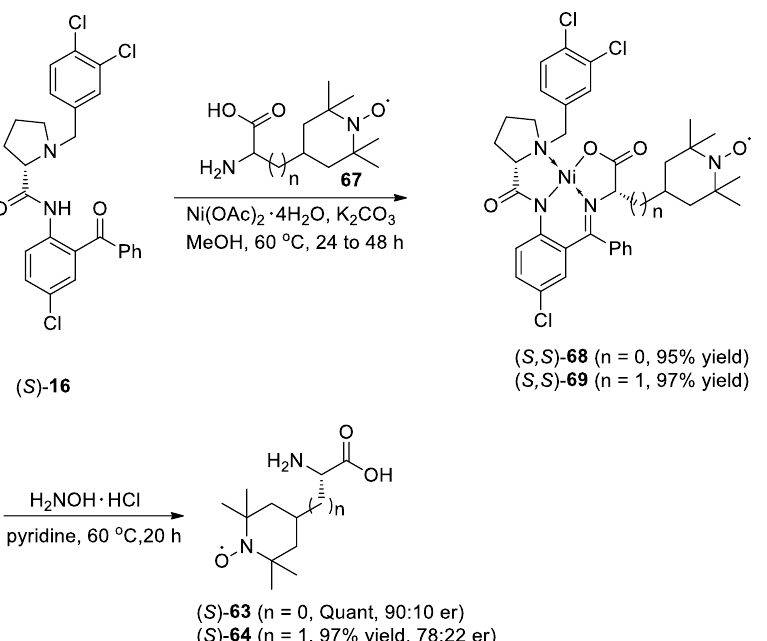
Scheme 24. Synthesis of chiral spin-labeled amino acids 63 and 64 .